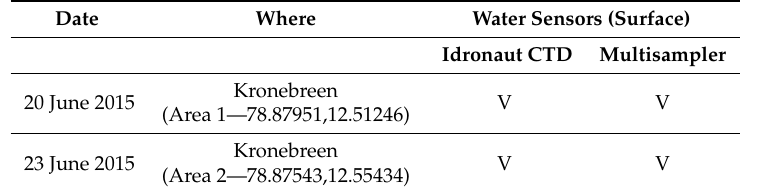
Table 1. ARCA project: Missions performed in Ny-Ålesund by Shark USSV in June 2015. Where